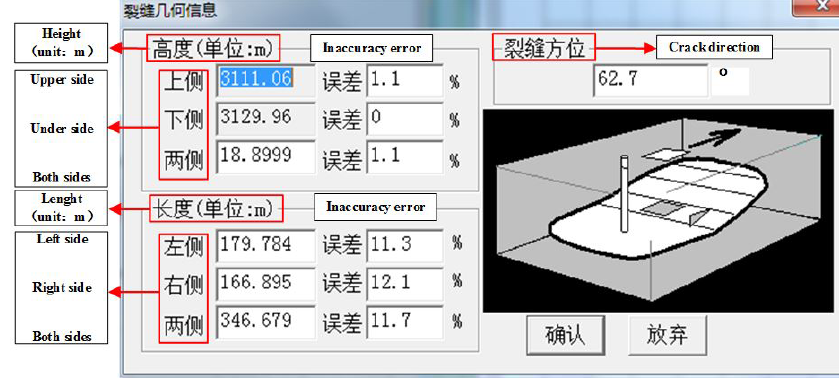
Figure 8. The upper computer monitors the geometric information of fracturing fractures.